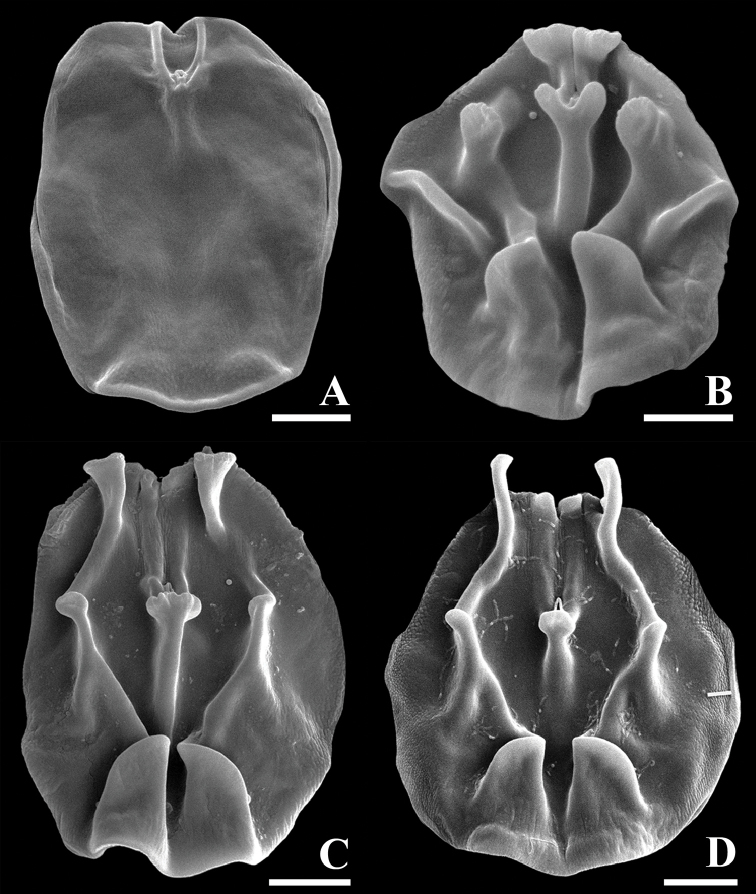
SEM photographs of dorsal plate (dorsal view). ALimniaslenis sp. n. BLimniasnovemceras sp. n. CLimniasmelicerta SH DLimniasmelicerta LH. Scale bars: 10 µm.